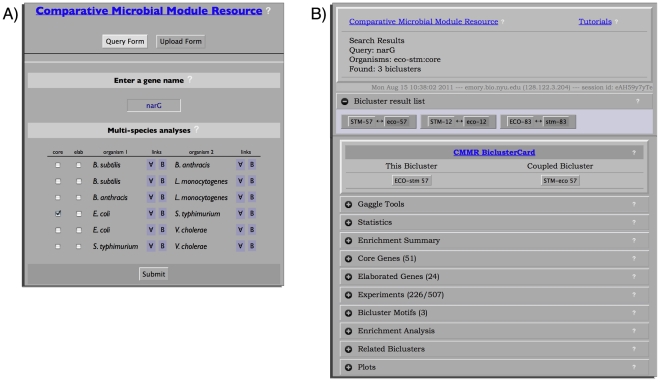
CMMR Query Page and BiclusterCard.The CMMR web interface allows users to search for biclusters of interest, with each resulting bicluster displayed in a BiclusterCard format. (A) The CMMR search page showing the title links to the CMMR wiki, query form button, upload form button, and input fields. Shown is the query form with an example search for narG in the core set (check box) of bicluster gene members for a MScM run of E. coli – S. Typhimurium. (B) The result page from this search – a user has access to the CMMR wiki, tutorials, a brief description of the search query, the resulting bicluster list and BiclusterCards. The BiclusterCard contains links to Gaggle tools, and expandable/collapsible tabs to display the bicluster's diverse supporting information. There are help icons with mouseover tooltips for descriptions and information.